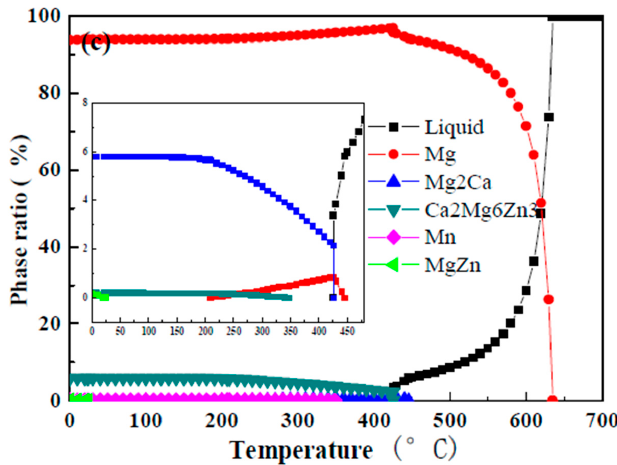
Figure 3. X-ray diffractions patterns of: ( a ) as-cast MZM-xCa alloys; and ( b ) homogenization state; and ( c ) JmatPro calculations results for the microstructure transformation of MZM-1.10% Ca alloy depending on temperature.